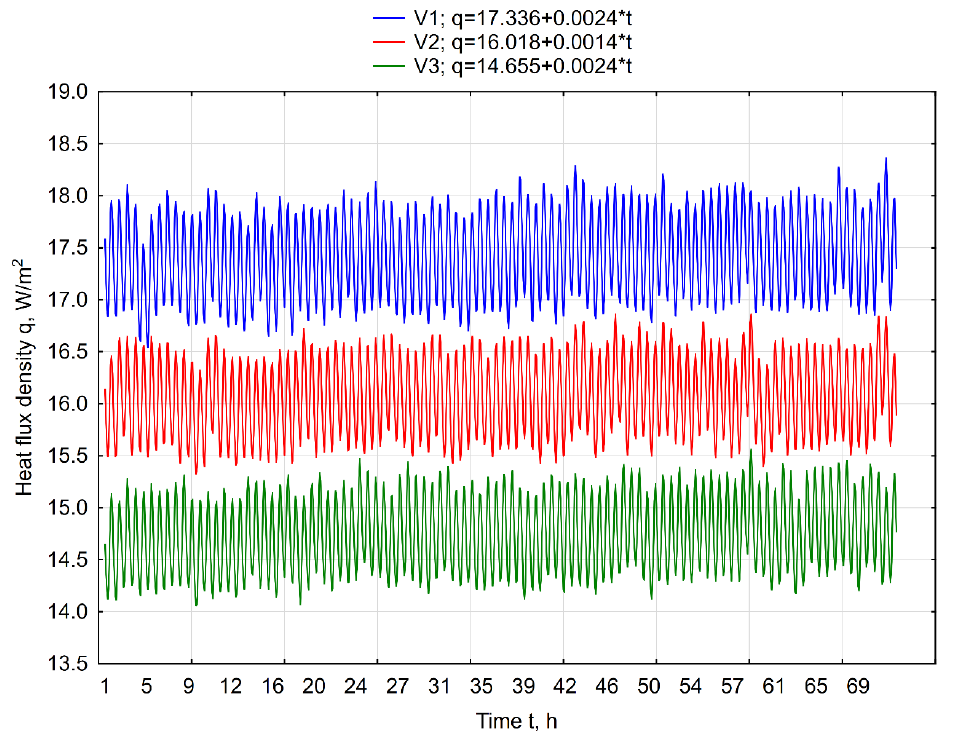
Figure 7. Charts of transformed time series for three partition variants.